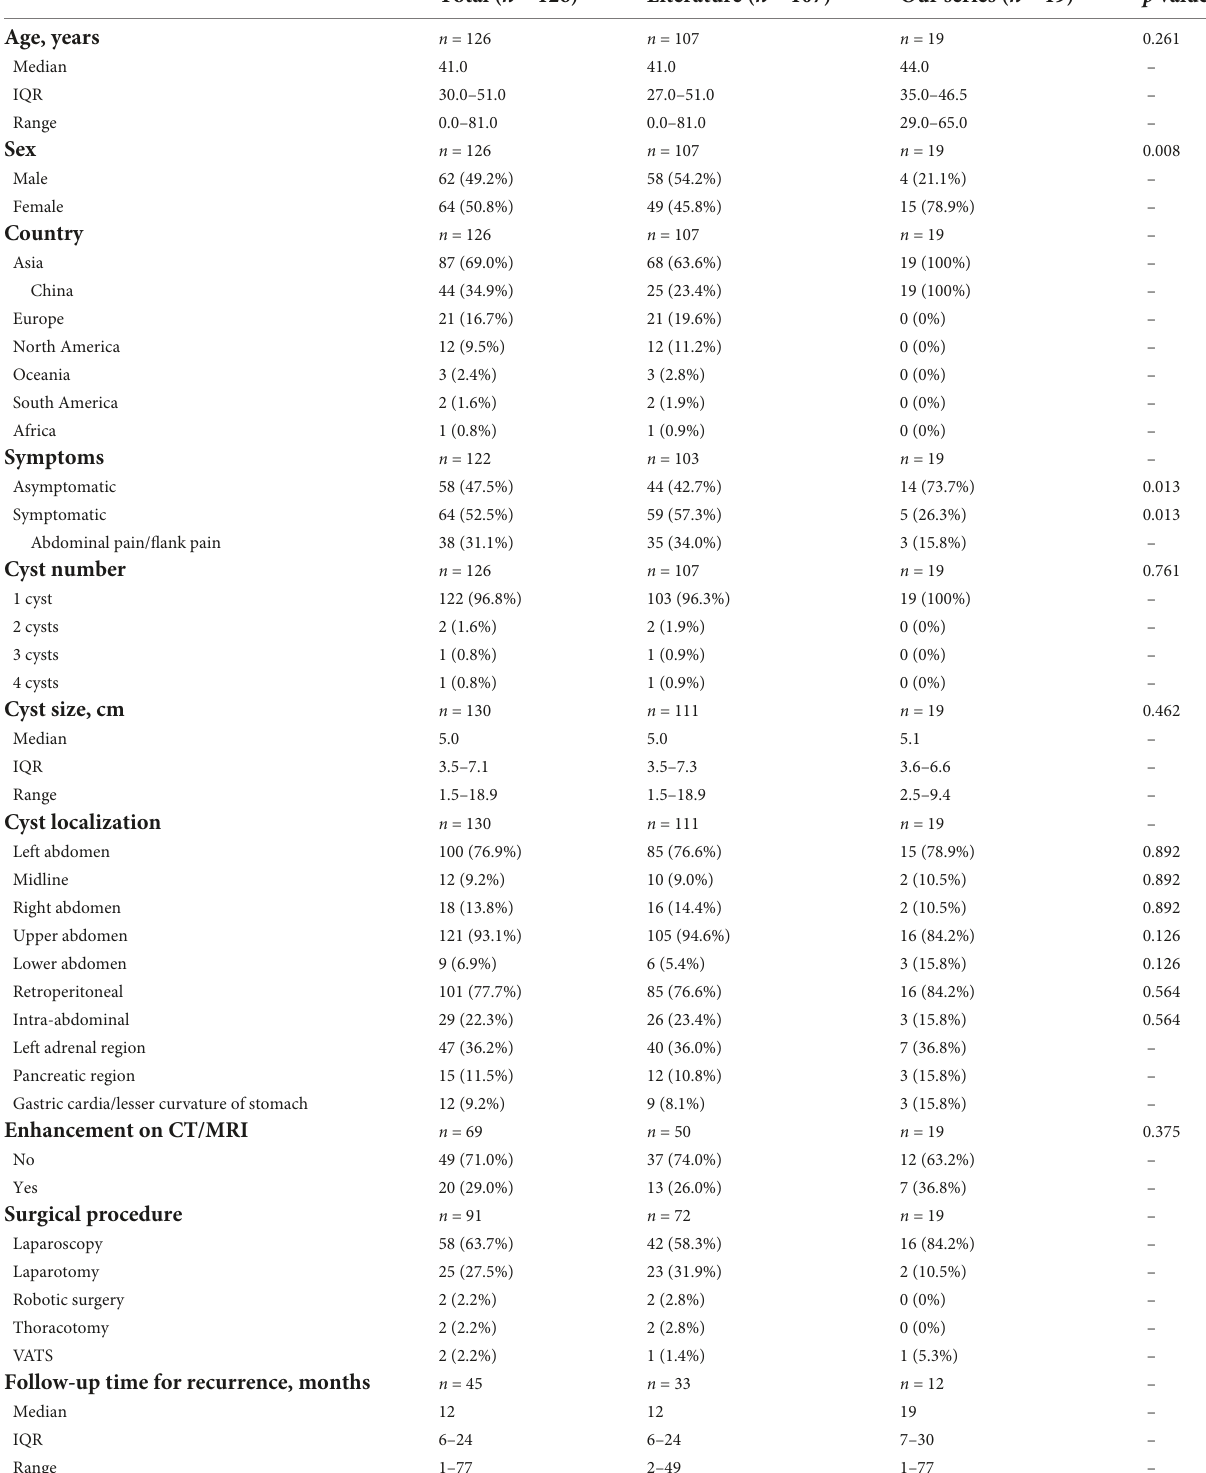
TABLE 3 Literature review and our series of subdiaphragmatic bronchogenic